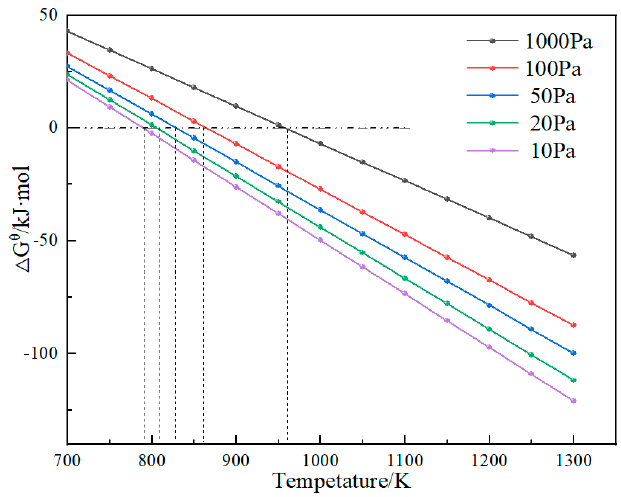
Figure 3. The Gibbs free energy at different vacuum degrees.